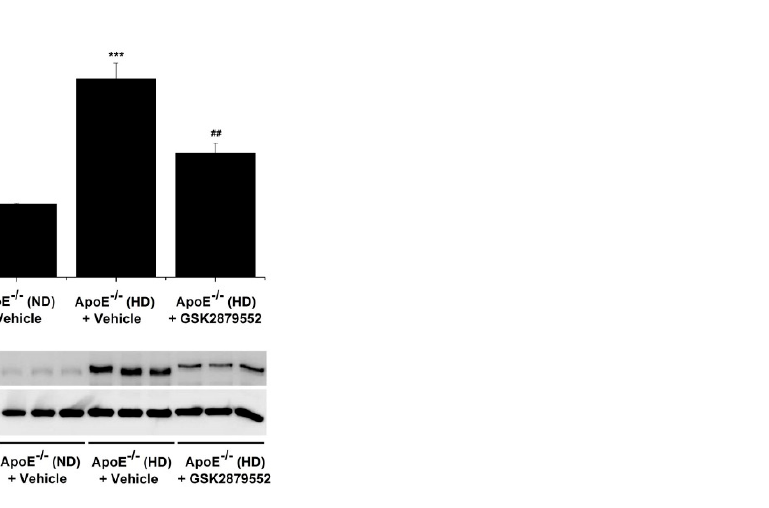
Figure 9. ( A ) Long-term pharmacological blockade of LSD1 function down-regulates the relative expression level of VCAM-1 protein in atherosclerotic ApoE-/- mice. ( B ) Representative immunoblot showing the modulation of aortic VCAM-1 protein level in ApoE-/- (HD) mice following GSK2879552 treatment. n = 3, *** p < 0.001. p -value was taken in relation to vehicle-treated ApoE-/- (ND) condition. ## p < 0.01. p -value was taken in relation to vehicle-treated ApoE-/- (HD) condition.